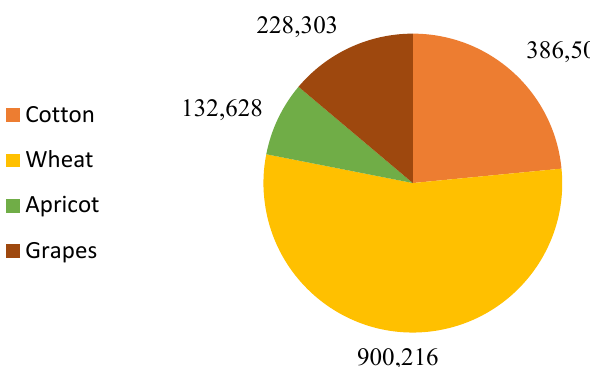
Figure 1. The average quantity of the main agricultural products obtained yearly in Tajikistan, tons. Data from [2].